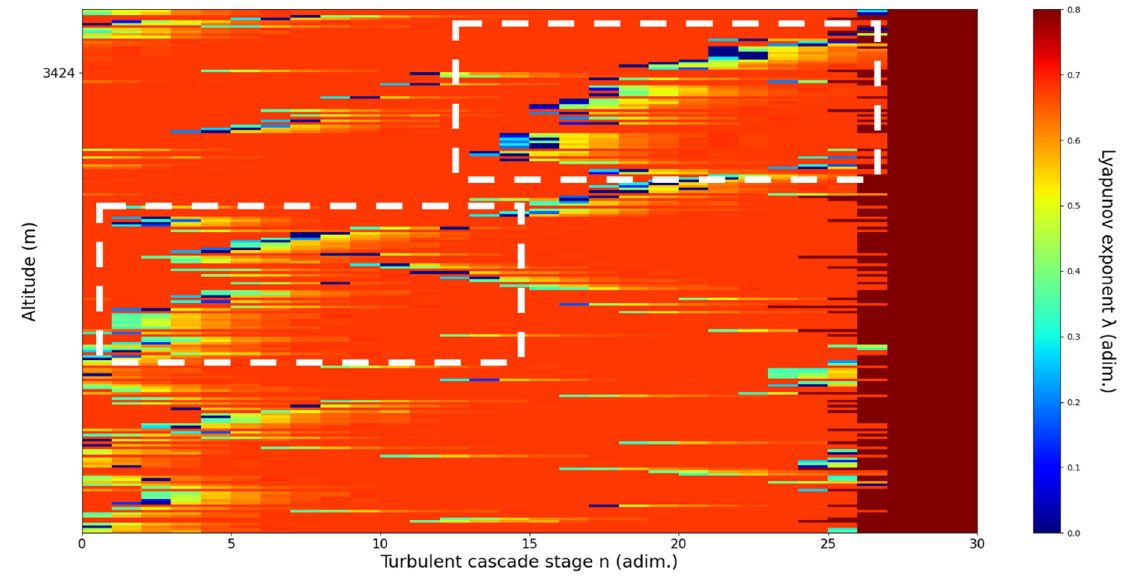
Figure 13. Lyapunov exponent per turbulent cascade stage colormap altitude plot, Bucharest, Romania, 13 June 2019, 07:10:00; point of interest: 3051 m.